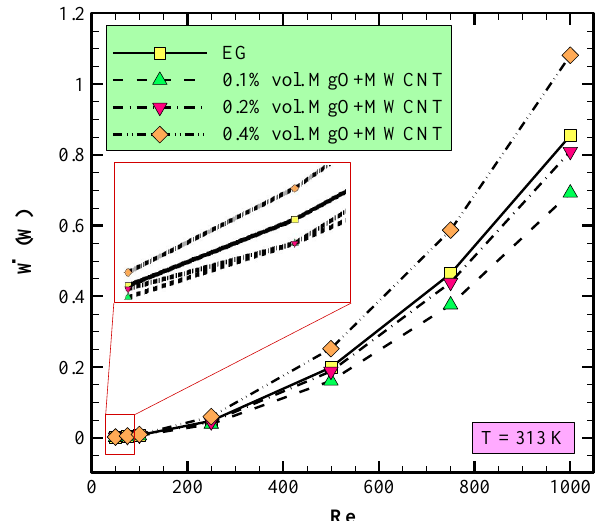
Figure 13. Influence of HNF with different VF on hydraulic power for different Re and inlet tem- perature T = 313 K.